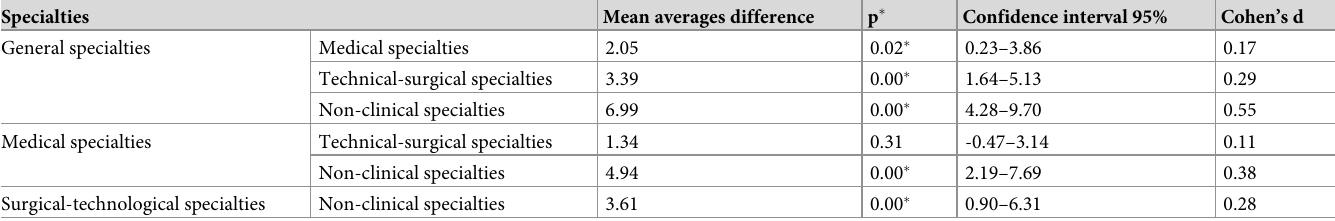
Table 4. Comparison of average Jefferson Scale of Empathy scores based on preference for a particular specialty. Specialties Mean averages